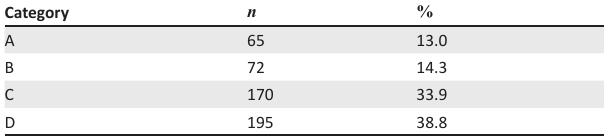
TABLE 1: Categories of public senior high schools ( N = 502) in